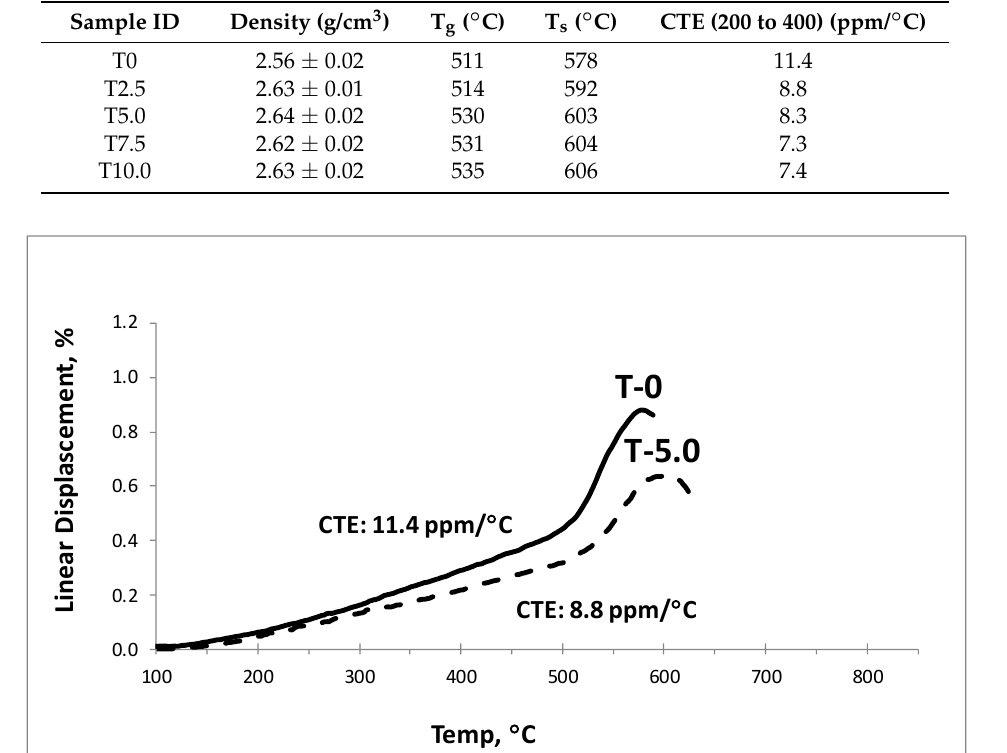
Table 4. Density and thermal properties of enamel glasses with silica addition.